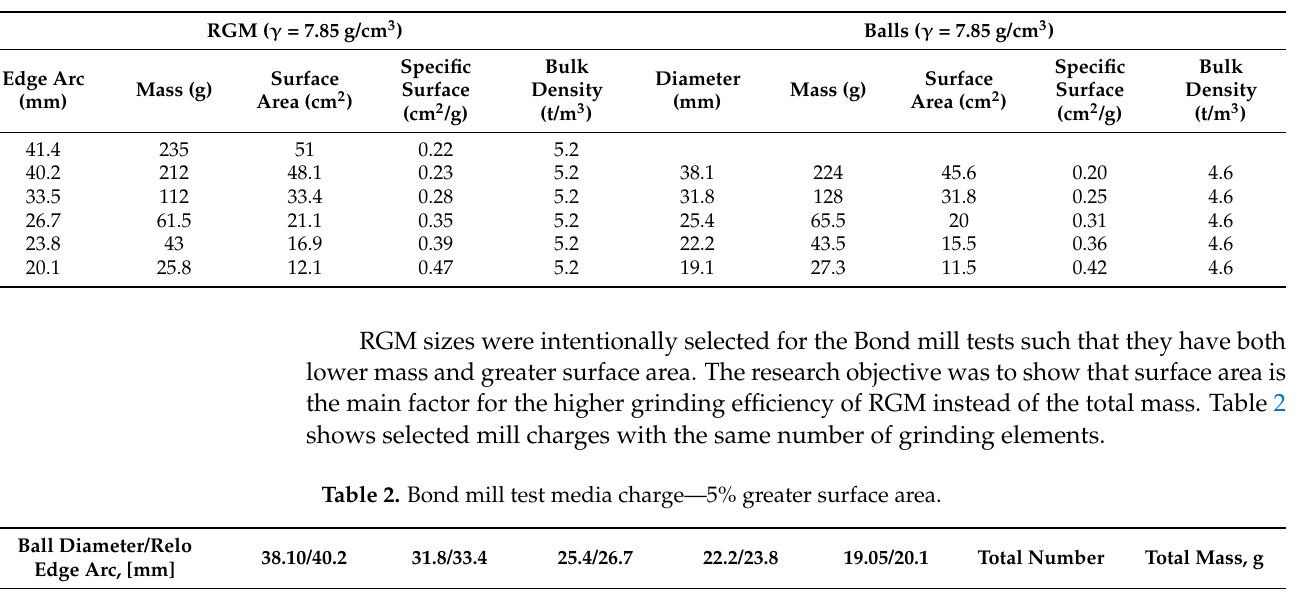
Figure 1. Grinding media charges: ( a ) Relo M-1 vs. balls ( b ) Relo M-2 vs. ball. Table 1. Comparative data of physical properties for RGM and balls.